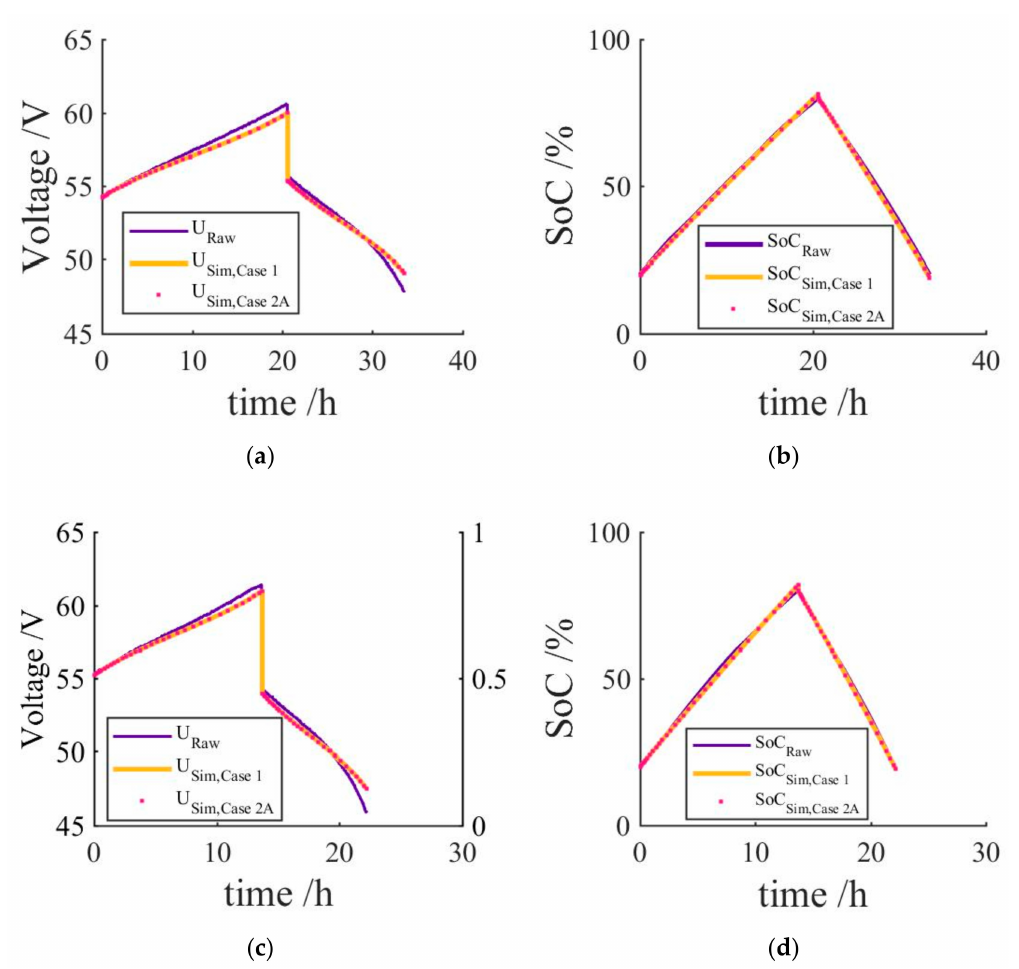
Figure 2. Comparison between simulation model and measurements using fitting Case 1 and Case 2A: ( a ) Voltage with P apl = 5 kW; ( b ) SoC with P apl = 5 kW; ( c ), Voltage with P apl = 7.5 kW; ( d ) SoC with P apl = 7.5 kW.